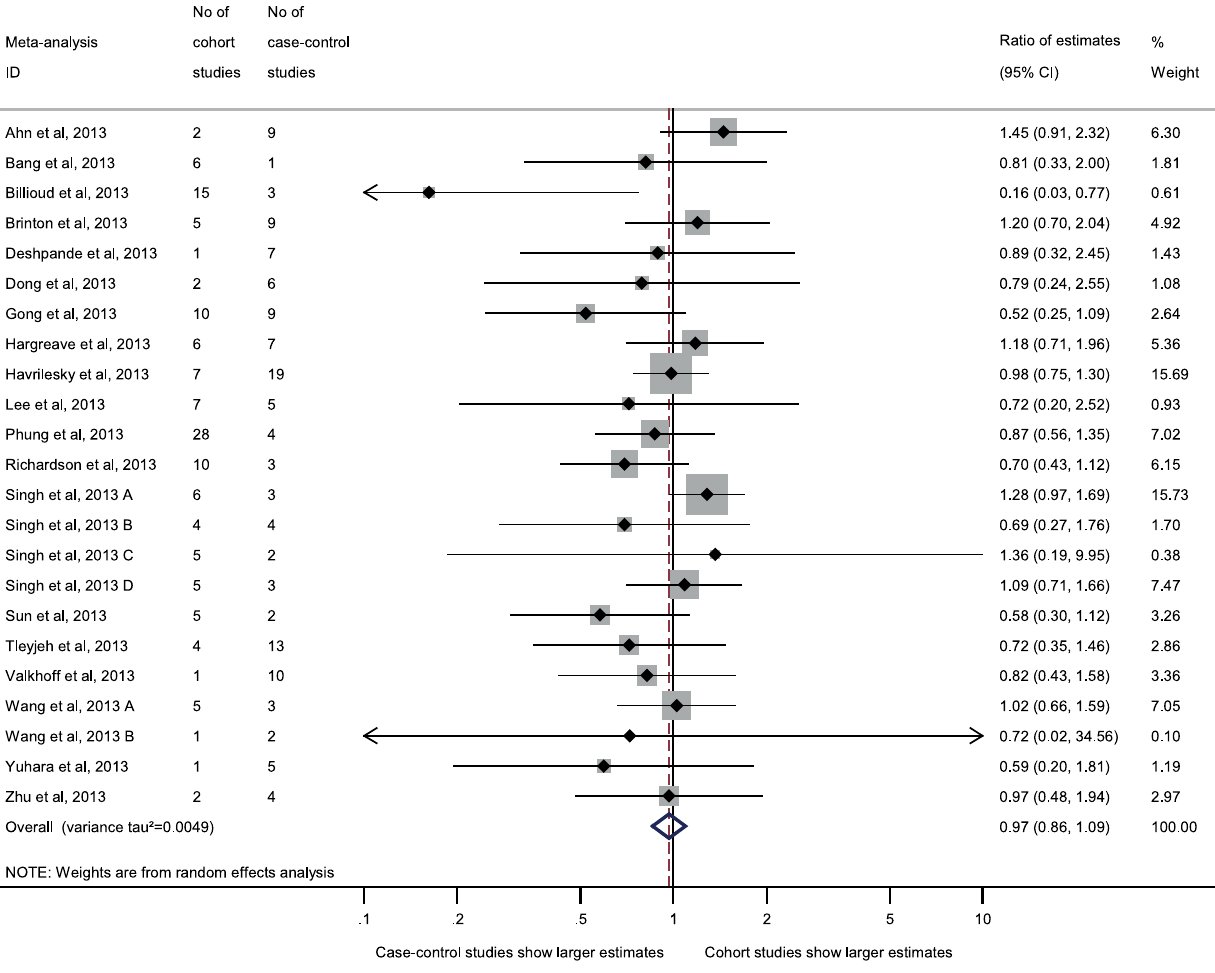
Fig 2. Difference in treatment effect estimates between 133 case – control and 138 cohort studies. Difference in treatment effect estimates is expressed as ratio of estimates (RE). A RE < 1 indicates that case – control studies yielded larger estimates of the intervention effect or adverse events than cohort